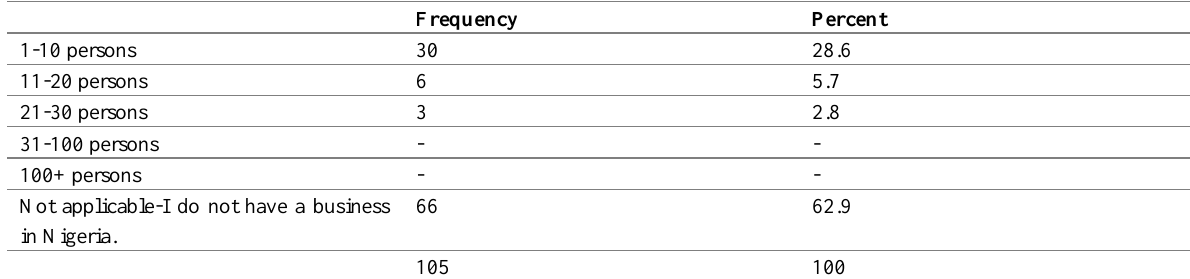
Table 3 : How many employees in your business